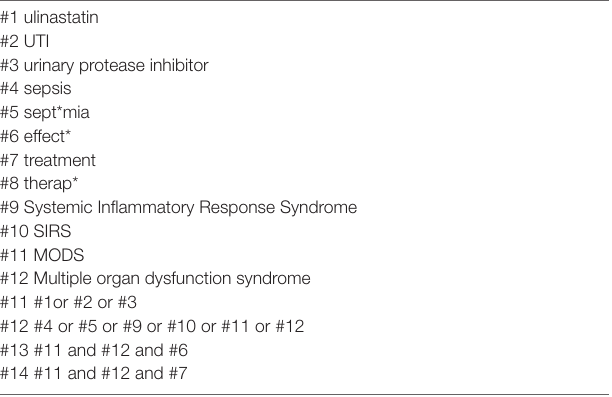
TABLe 1 | Search terms and phrases used in the